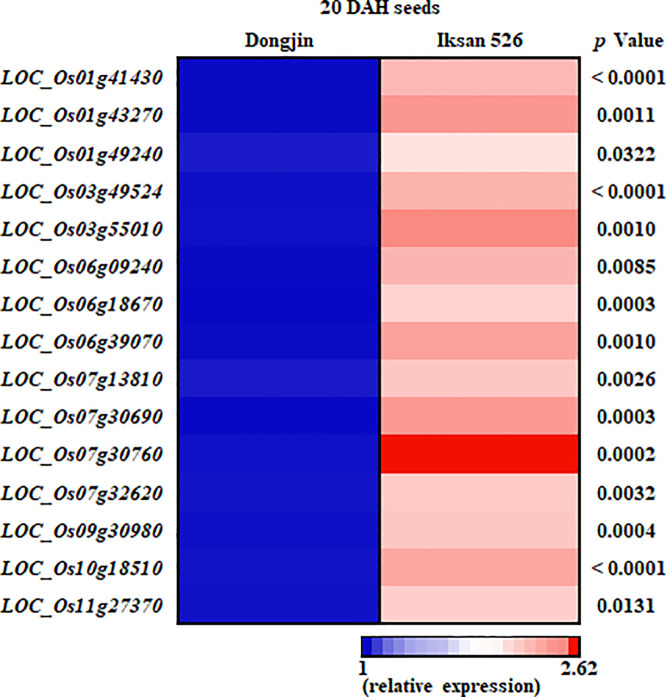
Verification of the expression level of selected UGTs (fold change ≥ 2) differentially expressed between Dongjin and I.526 seeds at 20 DAH by RT-qPCR.The p-values were obtained from the analysis of variance (ANOVA).